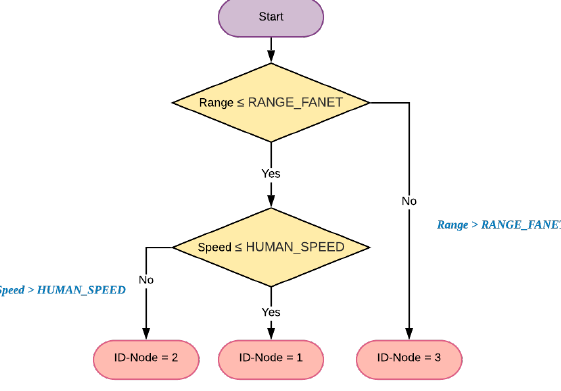
Figure 4. Identification organizational chart